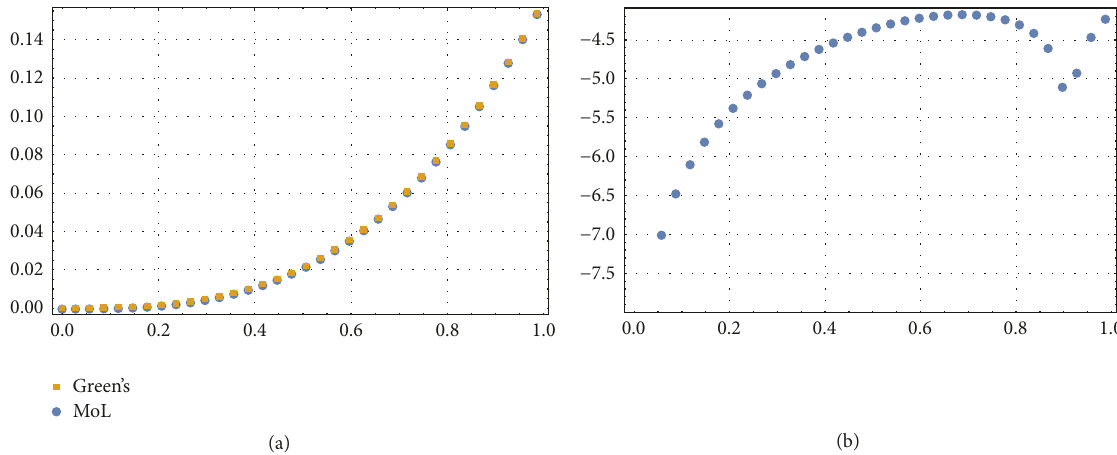
Figure 3: Discrete plot of 𝑤 and 𝑤 MoL (a) and Er (b) against 𝑡 ∈ [0,1] for 𝑓(𝑡) = sin (𝑡) : quadratic Green’s